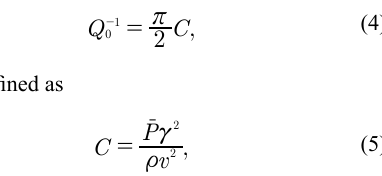
Figure 2. The internal friction Q film 1 - (a) and the relative change of speed of sound Δ v / v a 107 nm thick dry thermal oxide (a-SiO